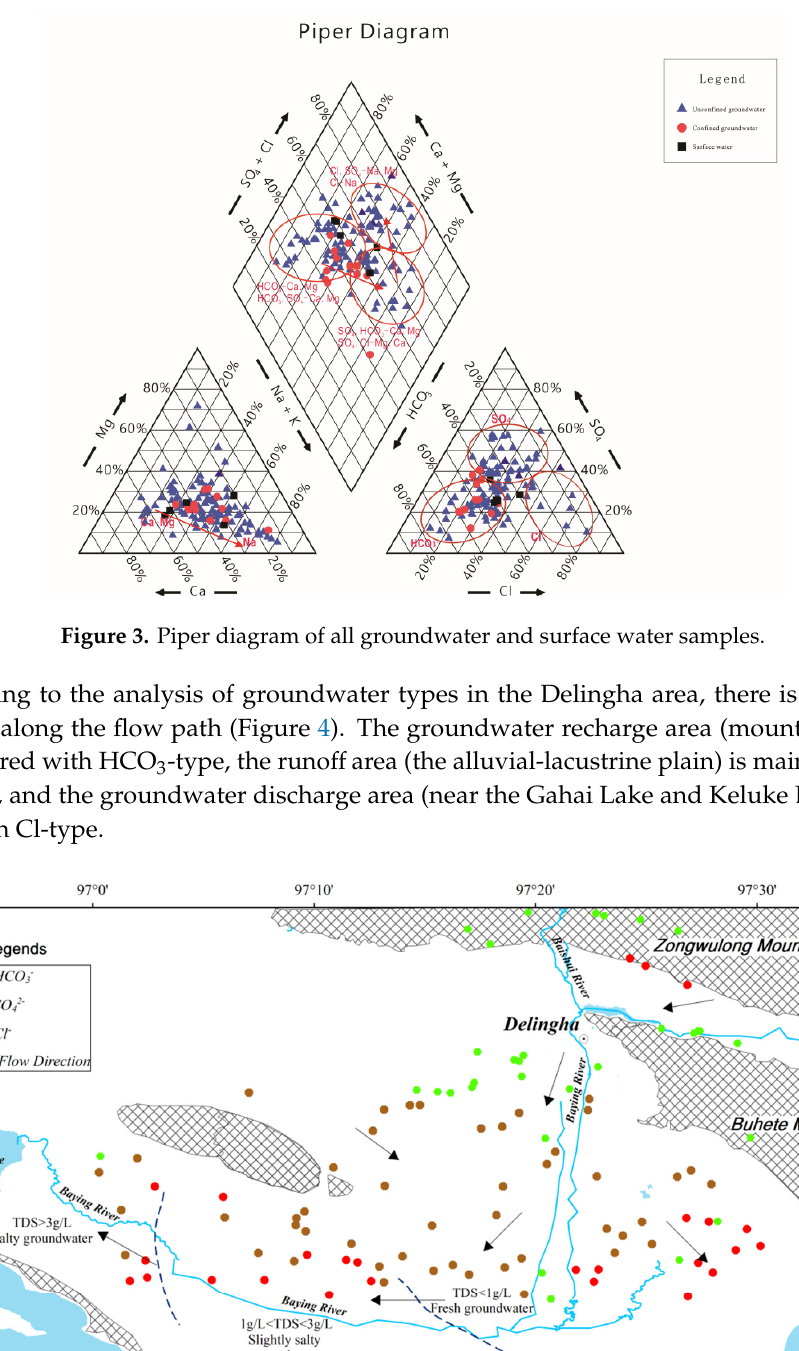
Figure 4. The distribution map of water types and Total Dissolved Solids (TDS) in the Delingha area.